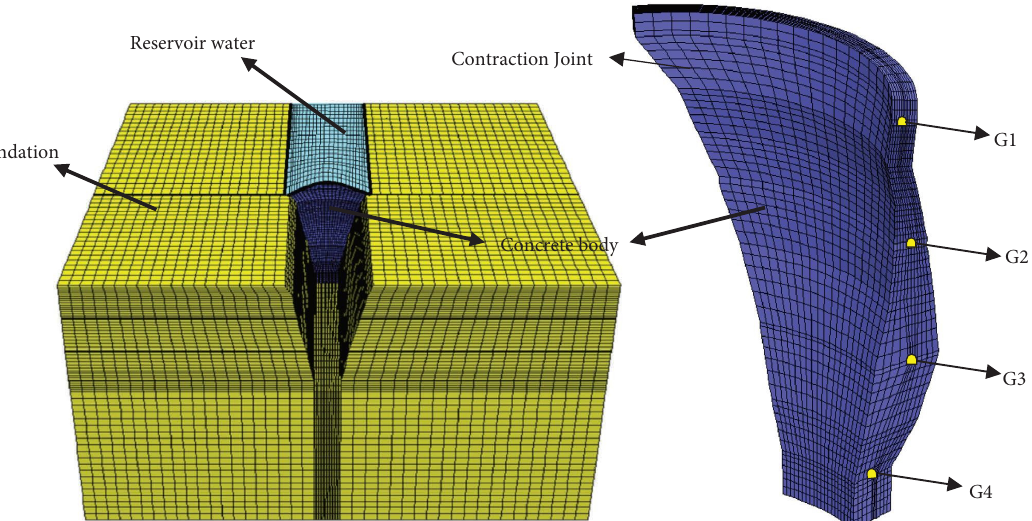
Figure 4: 3D FD model of Ermenek arch dam.